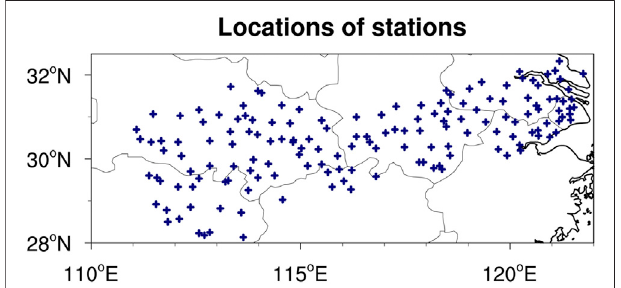
FIGURE 1 | Distribution of CMA stations over the